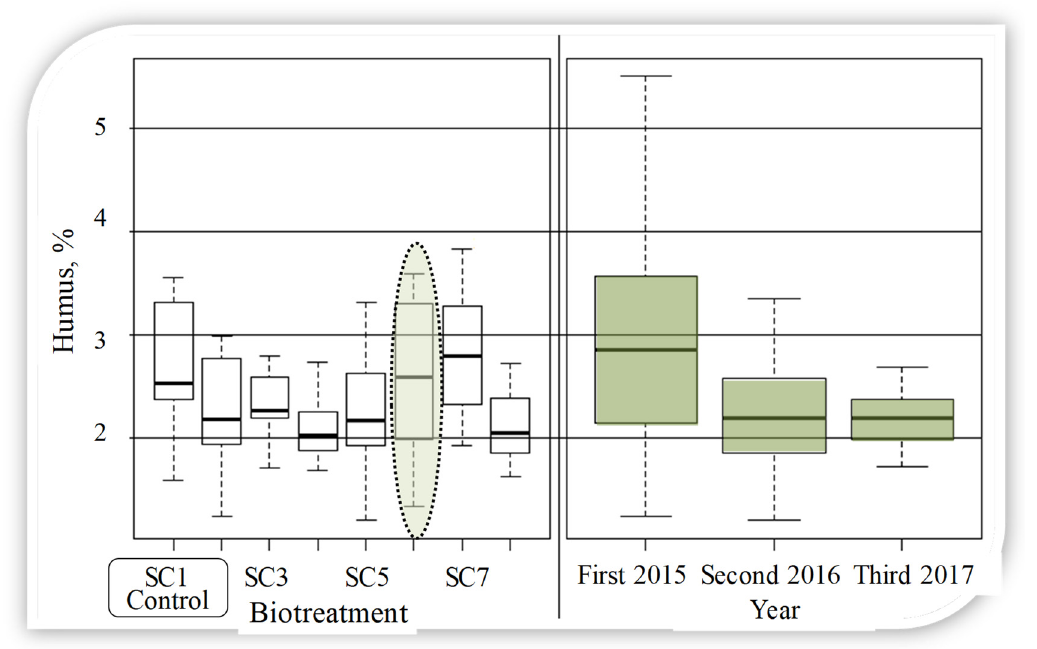
Figure 8. Humus (%) dependence on bio-impact(s) time (year) and scenario. Stability averages for 2015–2017 decreased, compared to those in 2015 and 2017. The highest value of stability was observed in SC6 all year. Stability values differed significantly (both by year and by scenario) ( p < 0.01) and were significantly different from year-to-year for scenario. The largest decrease was in SC4 (15.40%), with the lowest in SC3 (5.13) (Figure 9).